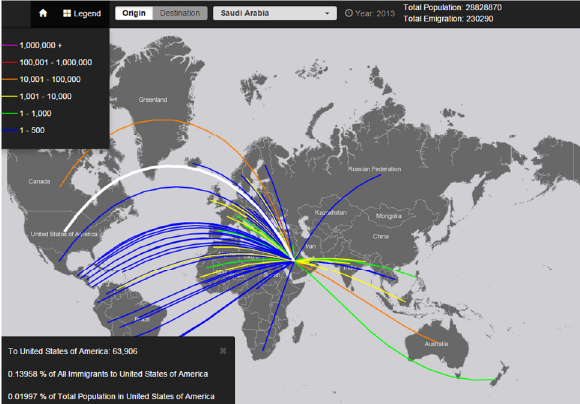
Figure 4b Emigrants from Saudi Arabia in